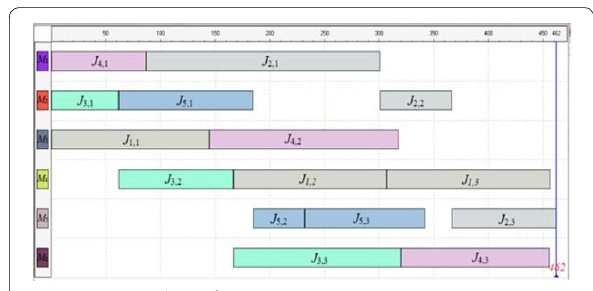
Figure 7 Gantt chart of instance MFJS01 (experiment